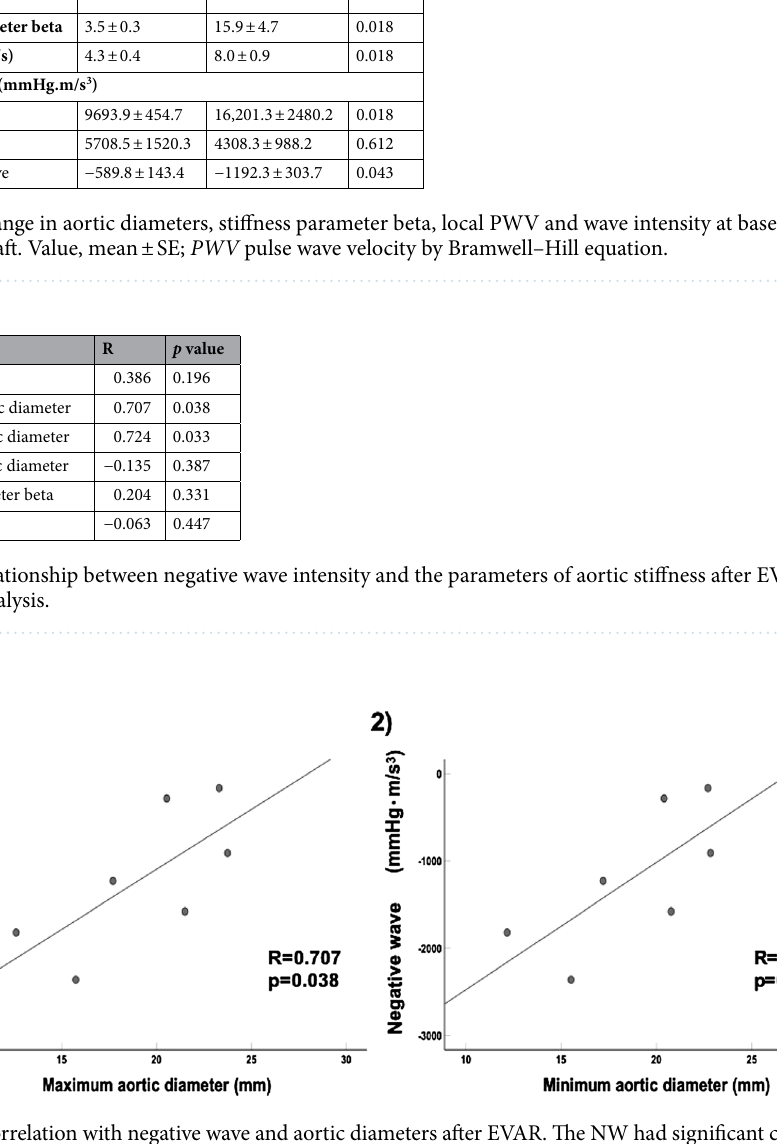
Figure 1. Correlation with negative wave and aortic diameters after EVAR. The NW had significant correlations with maximum aortic diameter ( 1 ) and minimum aortic diameter ( 2 ). The greater absolute values of NW show the greater of NW